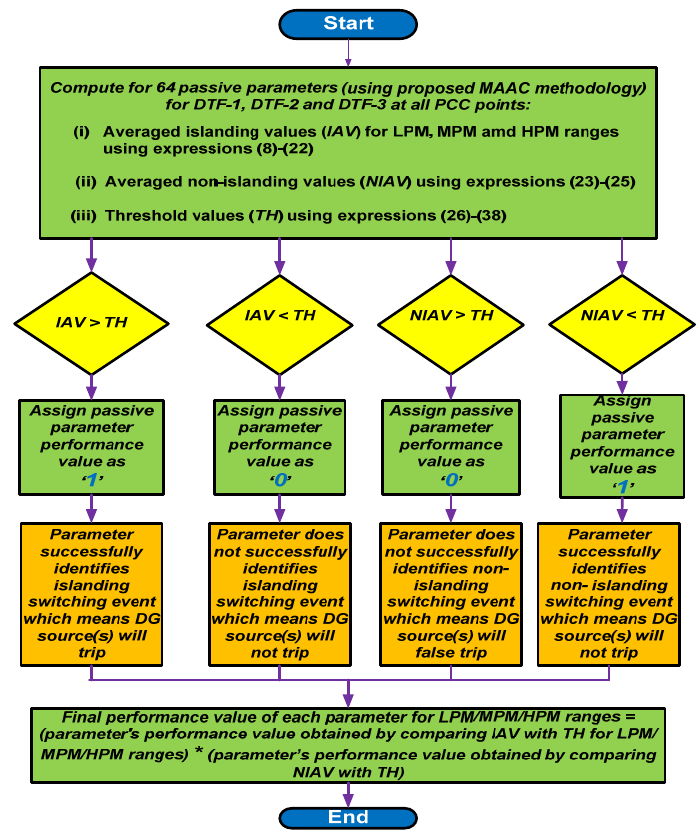
Figure 5. Flowchart for the prioritization of passive parameters through the proposed MAAC methodology.